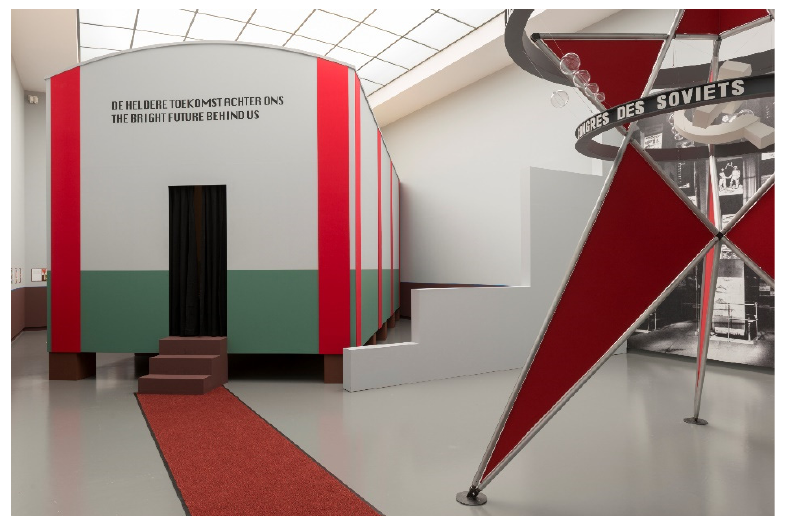
Figure 32. View of one of the rooms in the exhibition ‘Lissitzky–Kabakov: Utopia and Reality’, Van Abbemuseum, 2012. Front: part model after El Lissitzky, ‘Pressa Star’, 1927, reconstruction by Henry Milner, 2012. Van Abbemuseum. Back: Ilya Kabakov, ‘Let’s Go Girls’, 2012. Van Abbemuseum. Photo: Peter Cox.